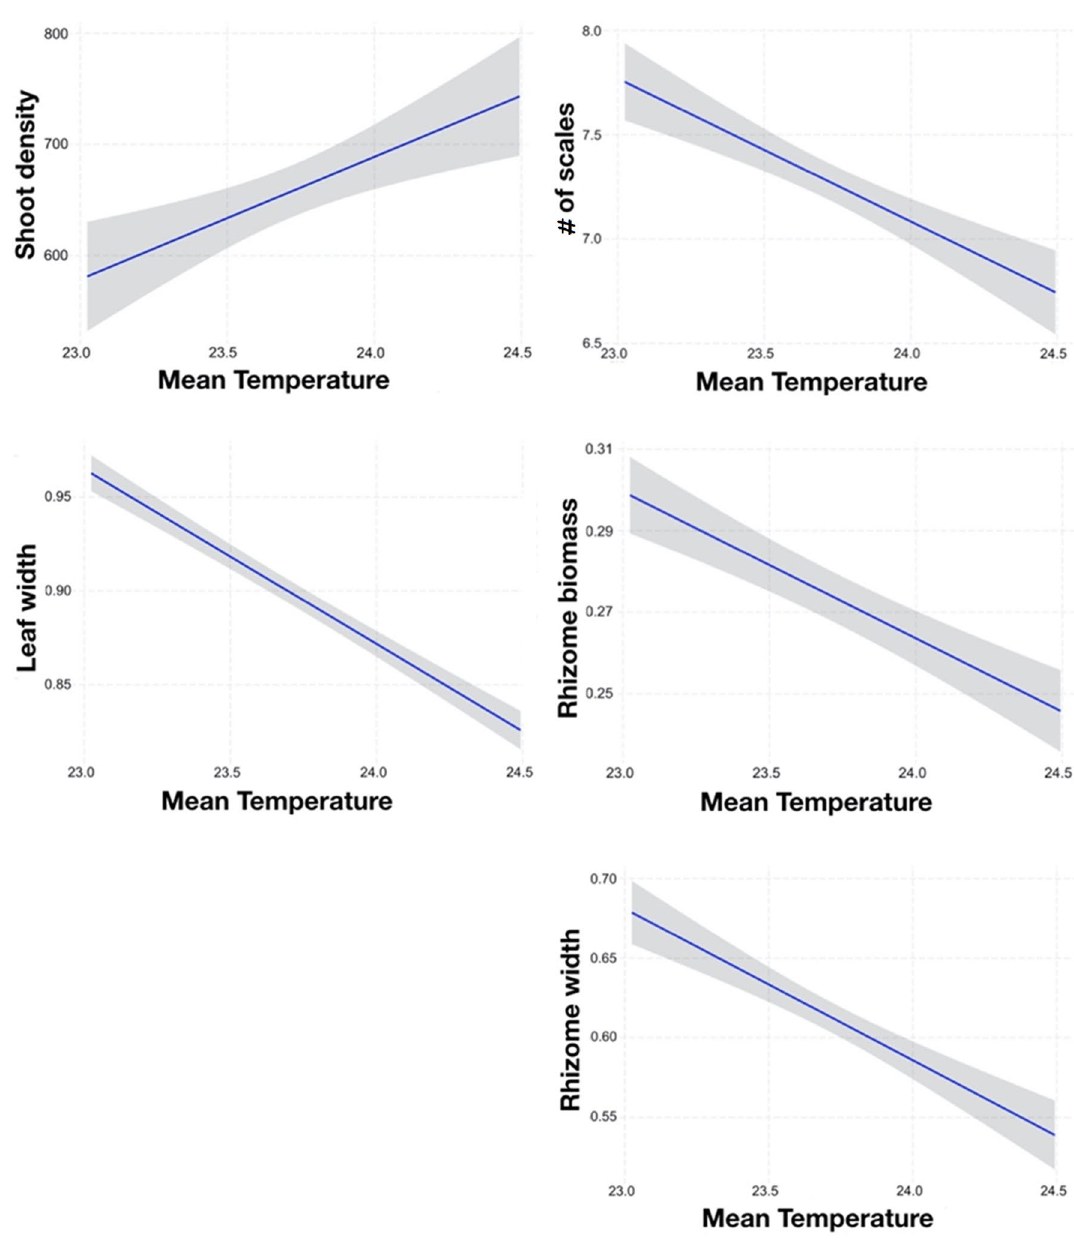
Figure 3. Plots from the multiple regression model of Posidonia oceanica response variables vs. mean temperature of leaves (by counting the scales), rhizome elongation, rhizome width and biomass per year were measured on each shoot (after drying rhizomes for 48 h at 60 °C). Data analysis. For each P. oceanica variable (shoot density, leaf length, leaf width, number of leaves, necrotic leaf portion, number of scales, rhizome elongation, rhizome width and rhizome biomass) a three-way anova was run to test the effect of ‘Coast’ (C, west vs east), ‘Location’ (L, 4 levels) random nested in C, and ‘Area’ (3 levels) random nested in L. Cochran’s test was used to test variance homogeneity. With the aim of finding a relationship between the P. oceanica and the explanatory variables (mean tempera- ture, maximum temperature, temperature variance, mean Chl-a, maximum Chl-a and Chl-a variance, Table 4), we ran separate multiple linear regression models for each P. oceanica response variables. No linear regres- sion was run on leaf length since it is largely affected by herbivore pressure, and it cannot be evaluated unless controlled experiments are performed 85 . Data exploration followed 86 : outliers were inspected with Cleveland dotplots (and removed in four cases) and normality with histograms and Q–Q plots. Rhizome biomass was